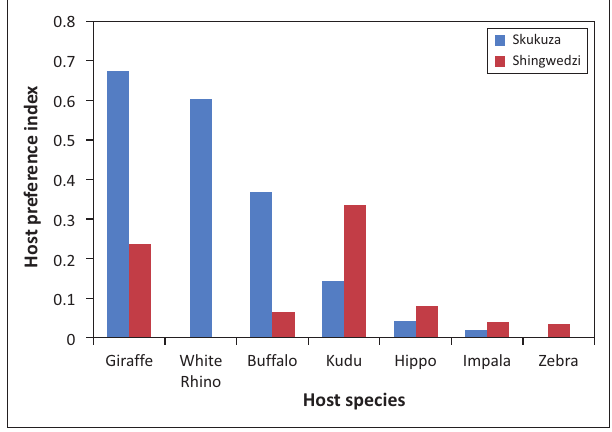
Skukuza Shingwedzi